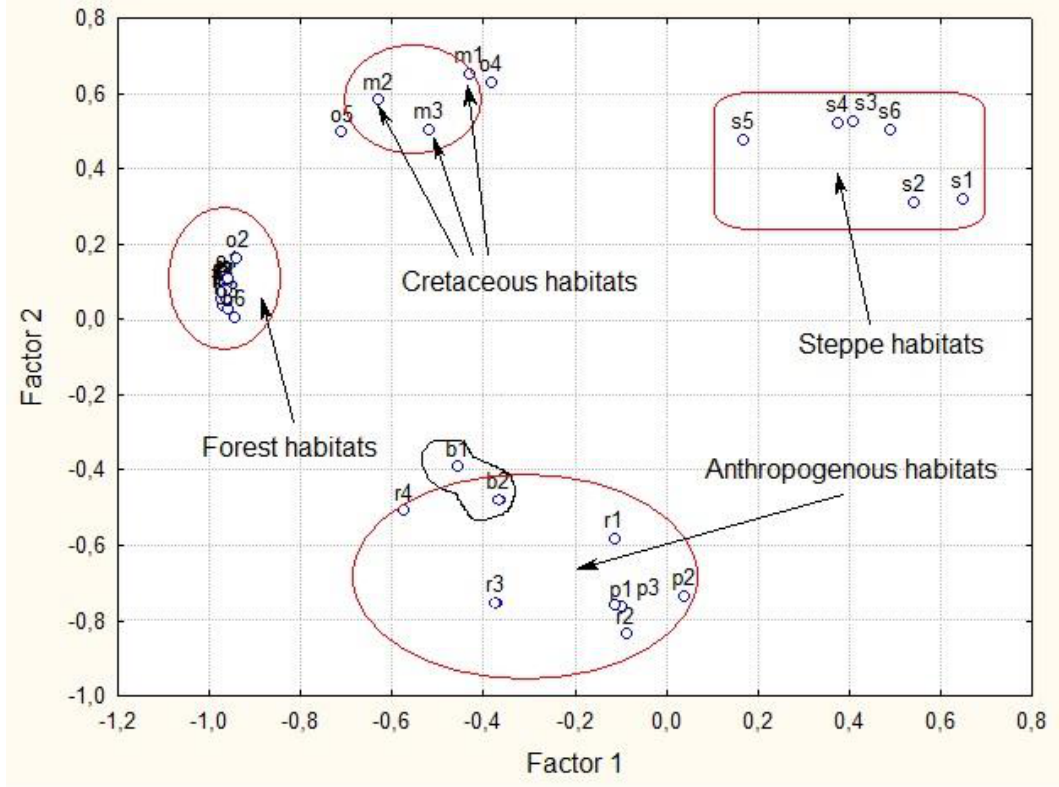
Fig. 1. Jaccard coefficient-based distribution diagram for groups of alien species colonizing various natural and anthropogenically transformed ecotopes in the two-factor space, symbols: b1–b2 – banks of water bodies and riverbanks; m1–m3 – chalk outcrops; f1–f8 – forest habitat areas; o1– o6 – gully systems; p1–p3 – parks; r1–r4 – railways; s1–s6 – steppe